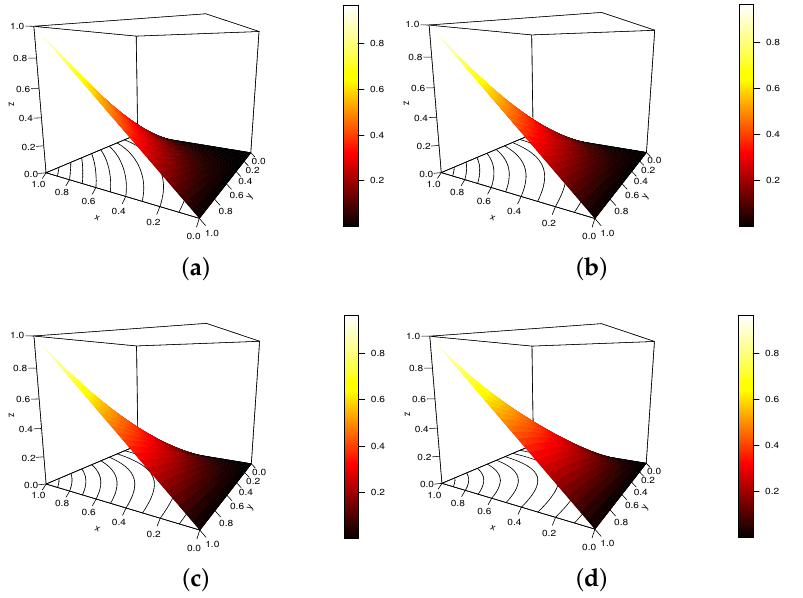
Figure 1. Display of the S copula for β = π /2, γ = 1, and ( a ) α = − 0.63, ( b ) α = − 0.15, ( c ) α = 0.15 and ( d ) α = 0.63.